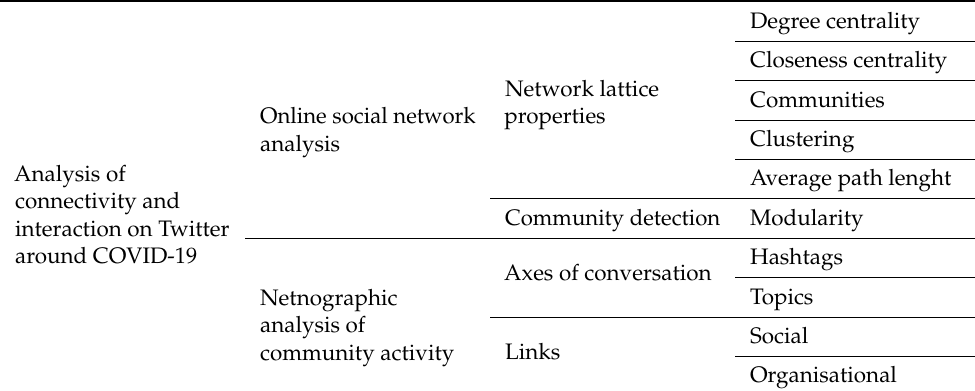
Table 1. Research